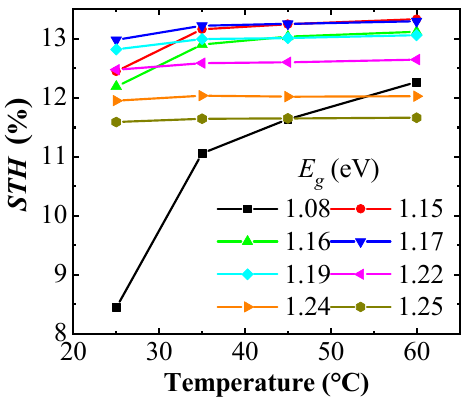
Figure 7. Solar-to-hydrogen ( STH) variation with the temperature of the NiMo–NiO electrolyzer for different 𝐸 (cid:3034) of the (A)CIGS module.